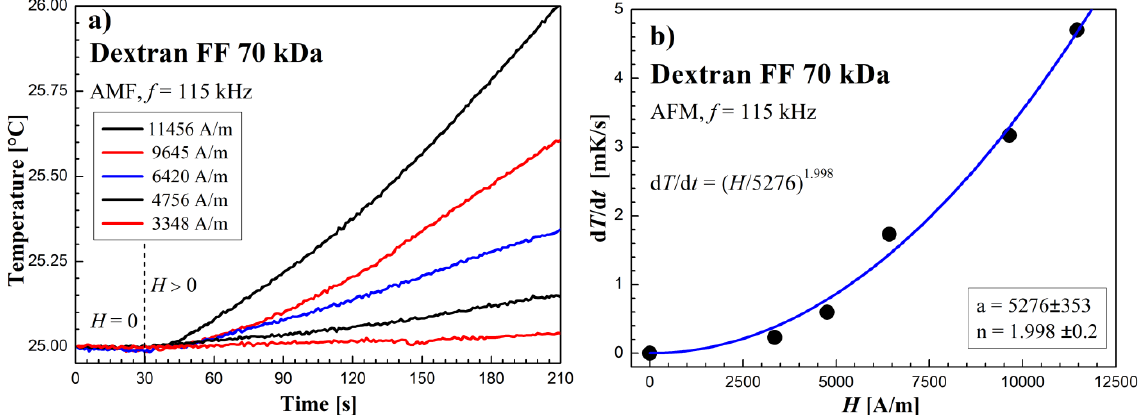
Figure 8. ( a ) Time courses of temperature changes in the dextran with magnetosomes sample. ( b ) d T /d t values depending on the amplitude of the magnetic field strength H in the RMF at the fre- quency f = 125 kHz.